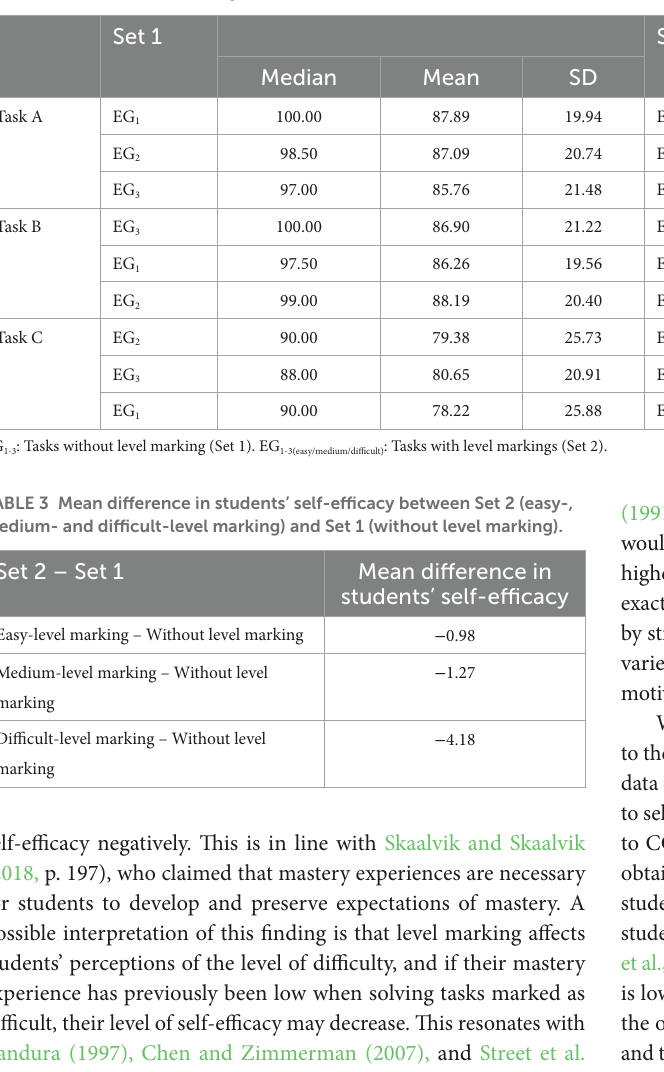
TABLE 2 Students’ self-efficacy in Set 1 and Set 2.